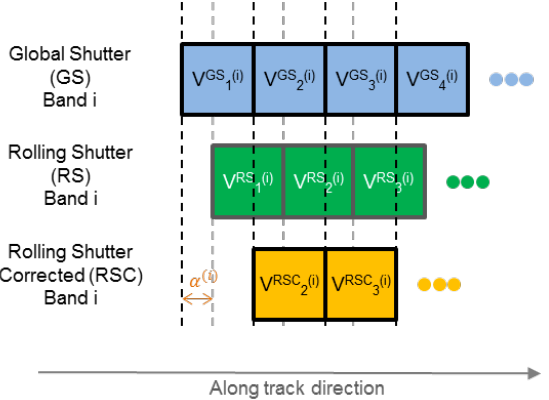
Figure 6. Illustration of RS effect in the along-track direction for band “i” with phase α (i)